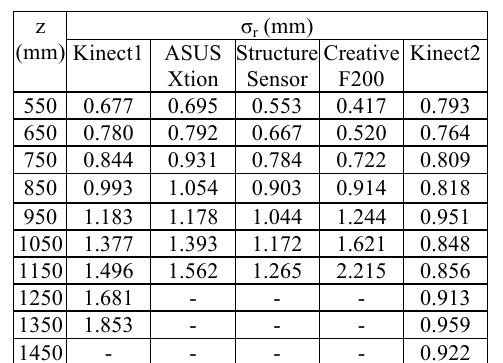
Table 1. Global measurement uncertainty vs. distance for the different sensors used in this test.